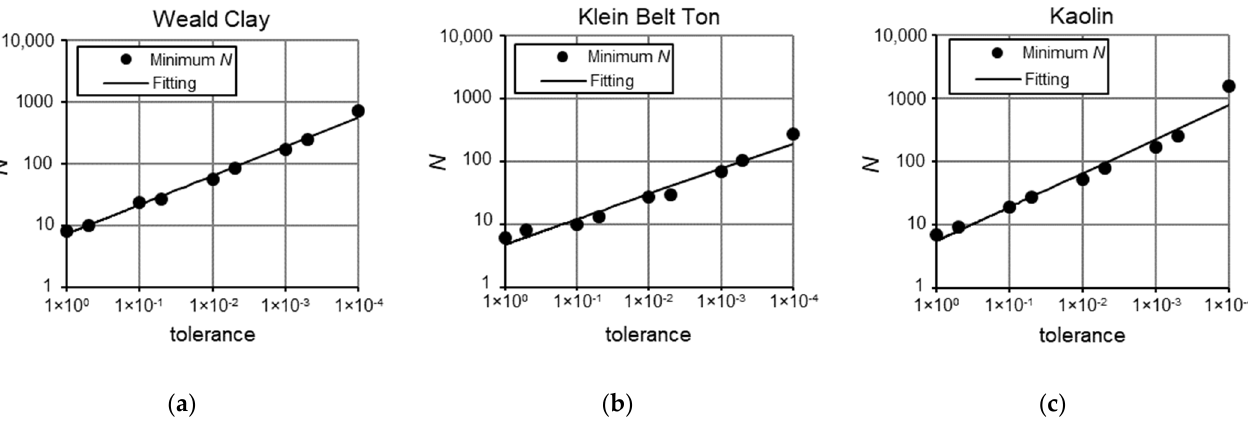
Figure 7. Fitting of the minimum number N of subdivisions of the yield surface is necessary to ensure a certain level of relative tolerance for any stress–strain path for ( a ) Weald Clay, ( b ) Klein Belt Ton and ( c ) Kaolin.